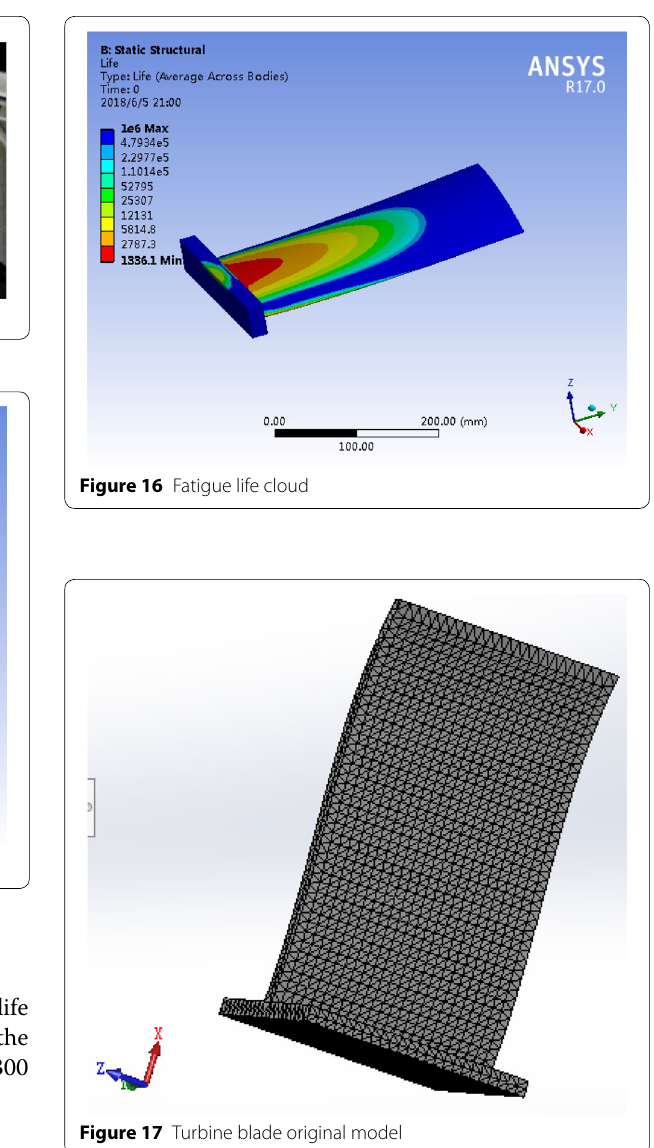
Figure 17 Turbine blade original